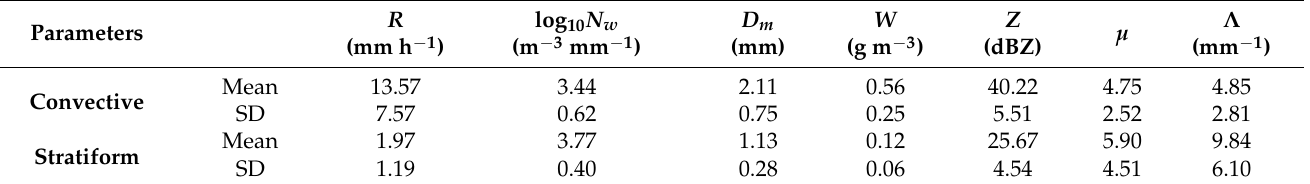
Figure 4. Mean raindrop concentrations (solid orange and olive-green lines) and the fitted normalized gamma distribution (dashed purple and red lines) for convective and stratiform rainfall in Zhaosu. Table 2. Several important rainfall parameters for convective and stratiform precipitation.